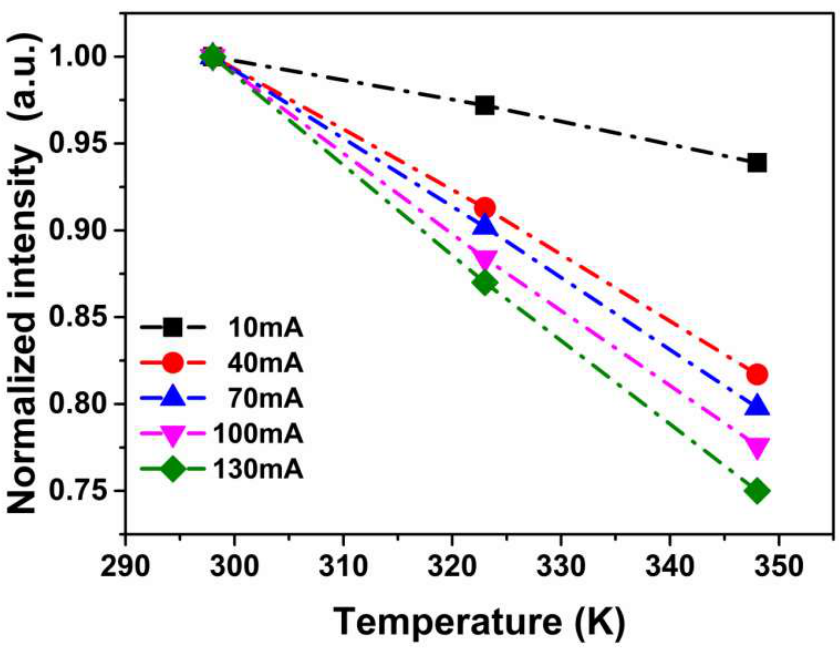
6 of 10 Figure 3. EL spectral data recorded at various forward currents and temperatures of 298, 323, and 348 K. ( a ) Spectral distributions, ( b ) main peak intensities, ( c ) parasitic peak intensities, and ( d ) peak intensity ratios. Figure 4 provides the normalized intensities of the peak wavelengths recorded at